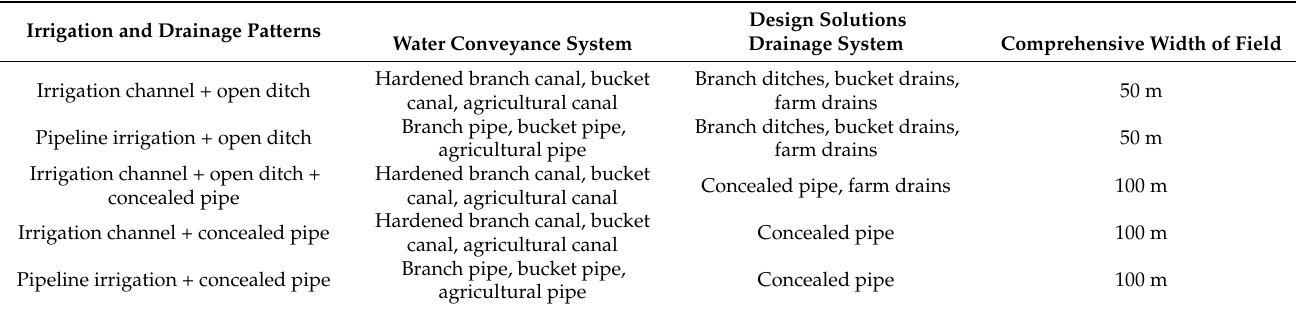
Table 2. Design options for different irrigation and drainage modes.